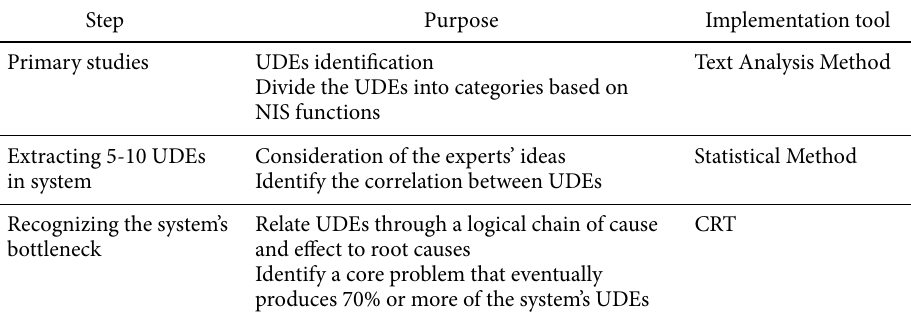
Table 3. Proposed algorithm for recognizing the bottleneck of Iran’s